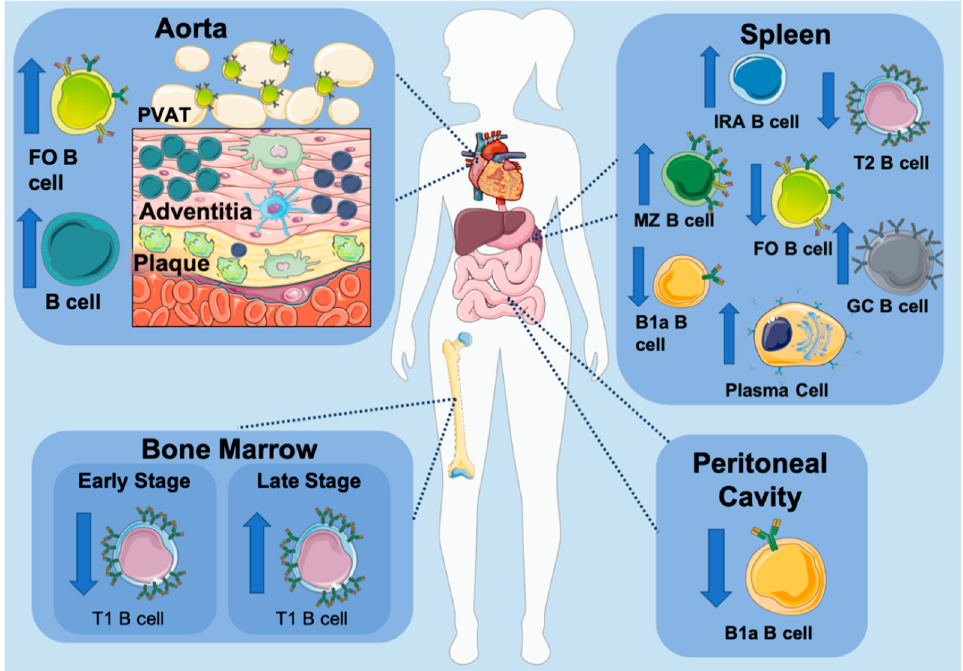
Figure 2. B cell subset development in atherosclerosis. Several animal studies have demonstrated that an atherosclerotic environment modulates B cell subset composition, evident by the altered distribution of B cells throughout the body. Artery tertiary lymphoid tissue (ATLO) located directly adjacent to plaques and the perivascular adipose tissue (PVAT) that surrounds the aorta contain an elevated number of B cells. The number of transitional B cells (T1) in bone marrow correlates with the progression of atherosclerosis with a decrease in early stage and increase in late stage. B1a B cells residing in the peritoneal cavity are decreased, while IRA B cells are significantly elevated in atherosclerosis. The spleen is the main reservoir of B cells and a center of humoral responses. Despite the decrease in transitional B cells (T2), MZ B cells are significantly increased in atherosclerosis. FO B cells are shown to either decrease or have no significant change despite the significant increase in germinal center (GC) B cells and plasma cells.